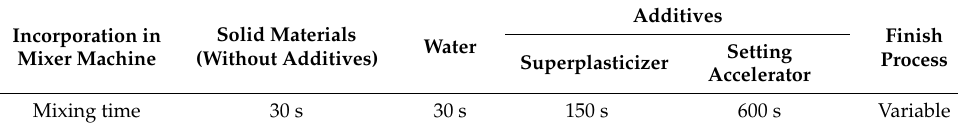
Table 3. Sequence of material incorporation.